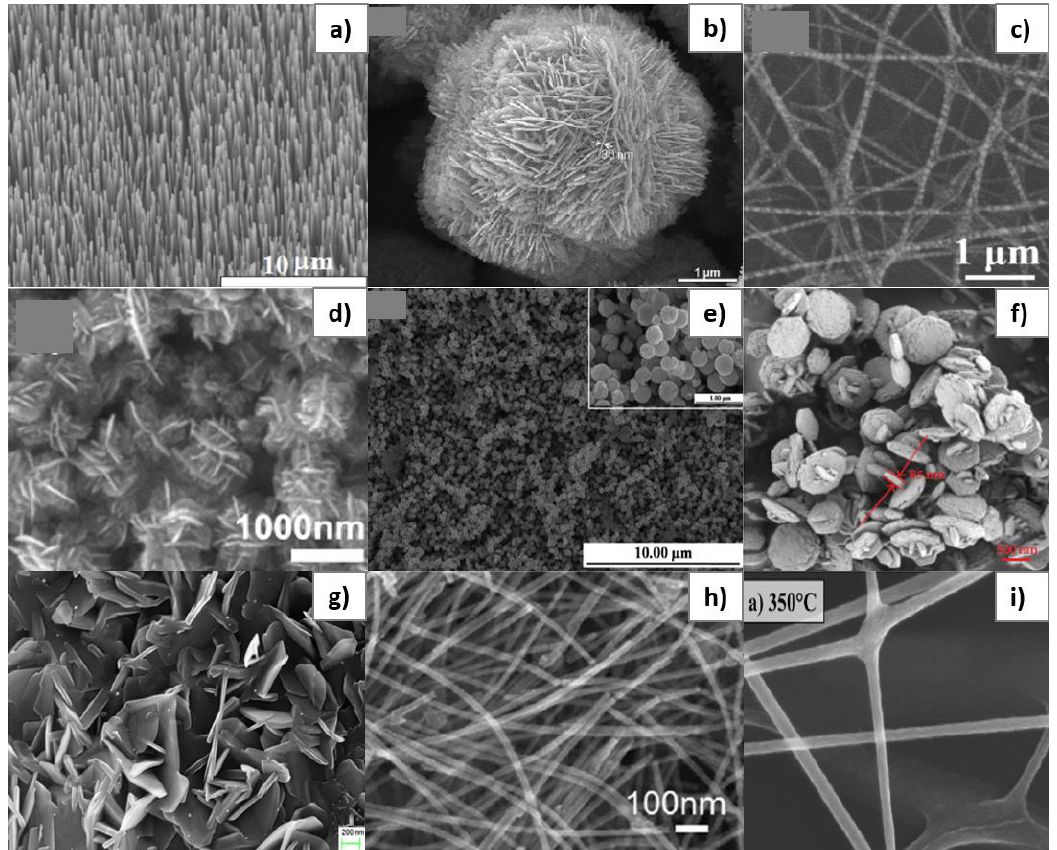
Figure 2. Scanning Electron Microscope (SEM) images for different types of morphologies obtained for ZnO: nanorods ( a ) [122], nanosheets ( b ) [132], nanotubes ( c ) [133], nanoflowers ( d ) [1], microspheres ( e ) [134], nanoplates ( f ) [113], nanoflakes ( g ) [135], nanowires ( h ) [136], and nanofibers ( i ) [137]. Reproduced (2020) with permission from Elsevier and ACS Publications.